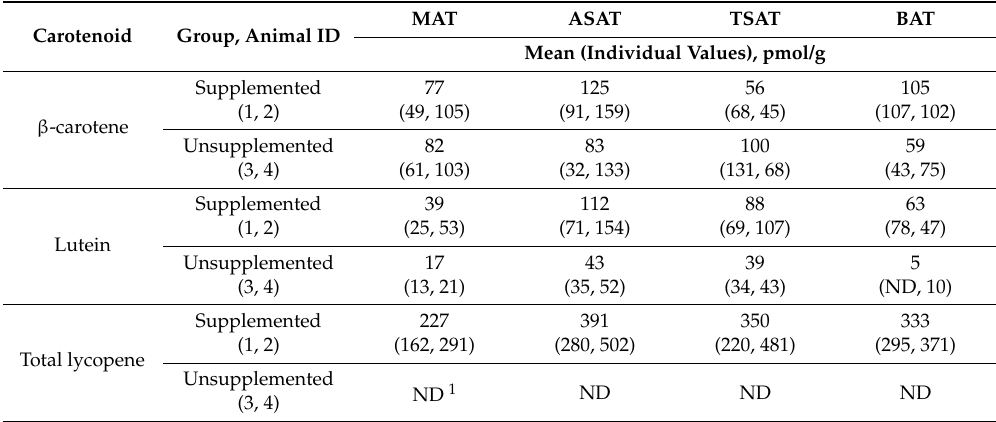
Table 3. β‐ carotene, lutein, and total lycopene concentrations in each adipose region.